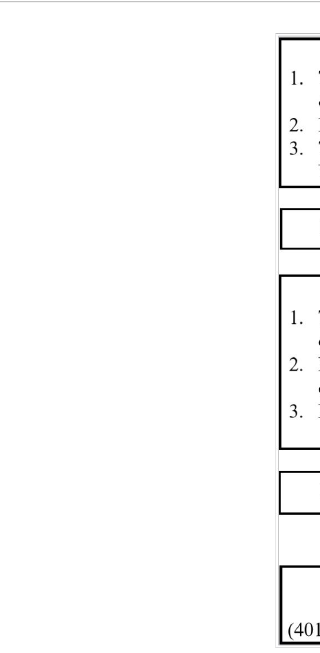
measured and its shear-wave velocity (SWV) was recorded as SWV1, which represents the average stiffness of the lesion; (ii) fi ve 3-mm- wide round ROIs were selected for measurement; four of them were placed at locations adjacent to the lesion (including peritumoral and intratumoral tissues), and one ROI was placed inside of the lesion, and the average SWV was recorded as SWV5, which represents the